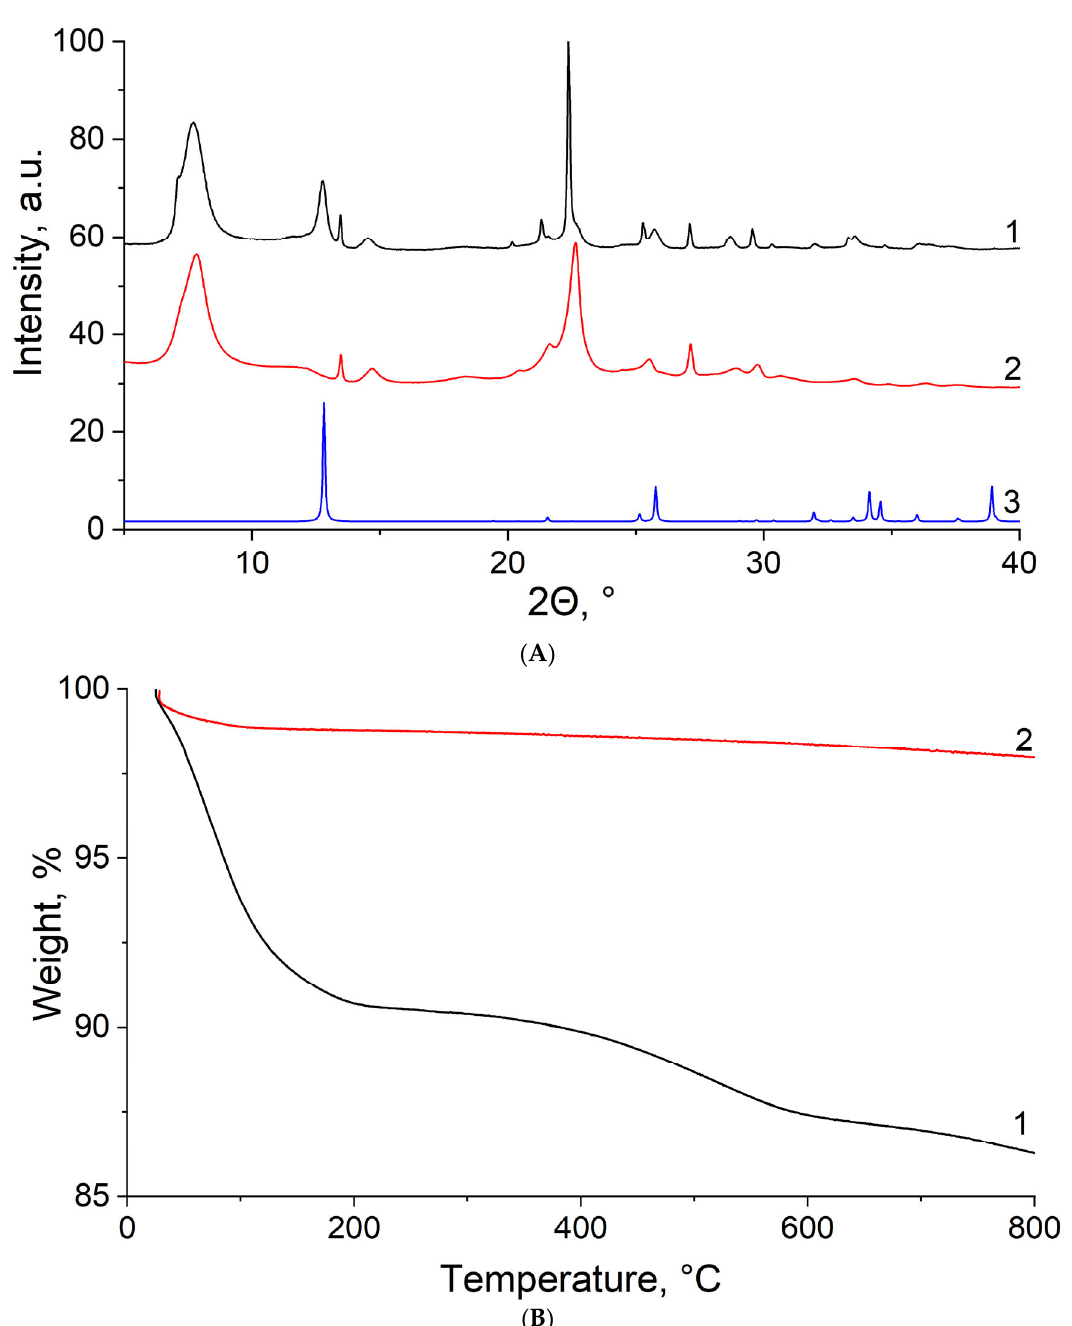
Figure 8. ( A ) XRD patterns of CuSn ‐ BEA (1), BEA ‐ 19 (2) and calculated Cu 2 (NO 3 )(OH) 3 (3); patterns are offset for clarity. ( B ) TGA curves of MOR (1) and Sn ‐ BEA (2). are offset for clarity. ( B ) TGA curves of MOR (1) and Sn-BEA